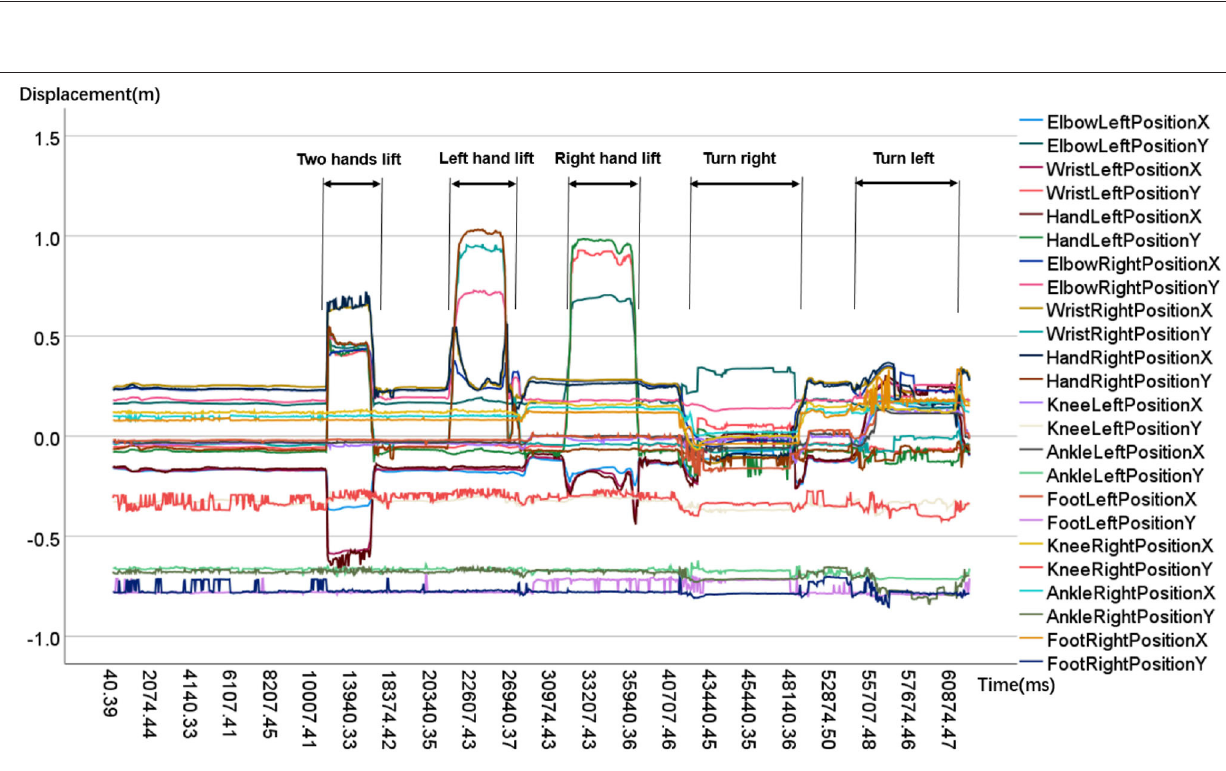
Frontiers in Neurology |